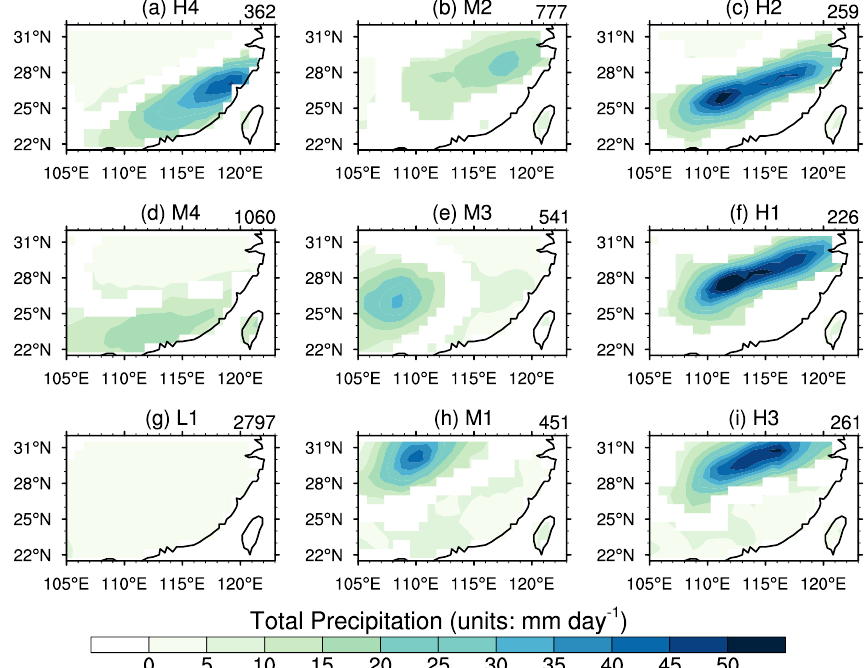
Figure 4. ( a – i ) Composite means of precipitation (units: mmday − 1 ) for the nine regimes during AMJ 1979–2015. The number of samples belonging to each regime is shown at the top right of each panel. Only composite means that pass the 95% confidence level based on two-sided Student’s t test against the complementary set of samples (i.e., the samples not belonging to a specified regime) are